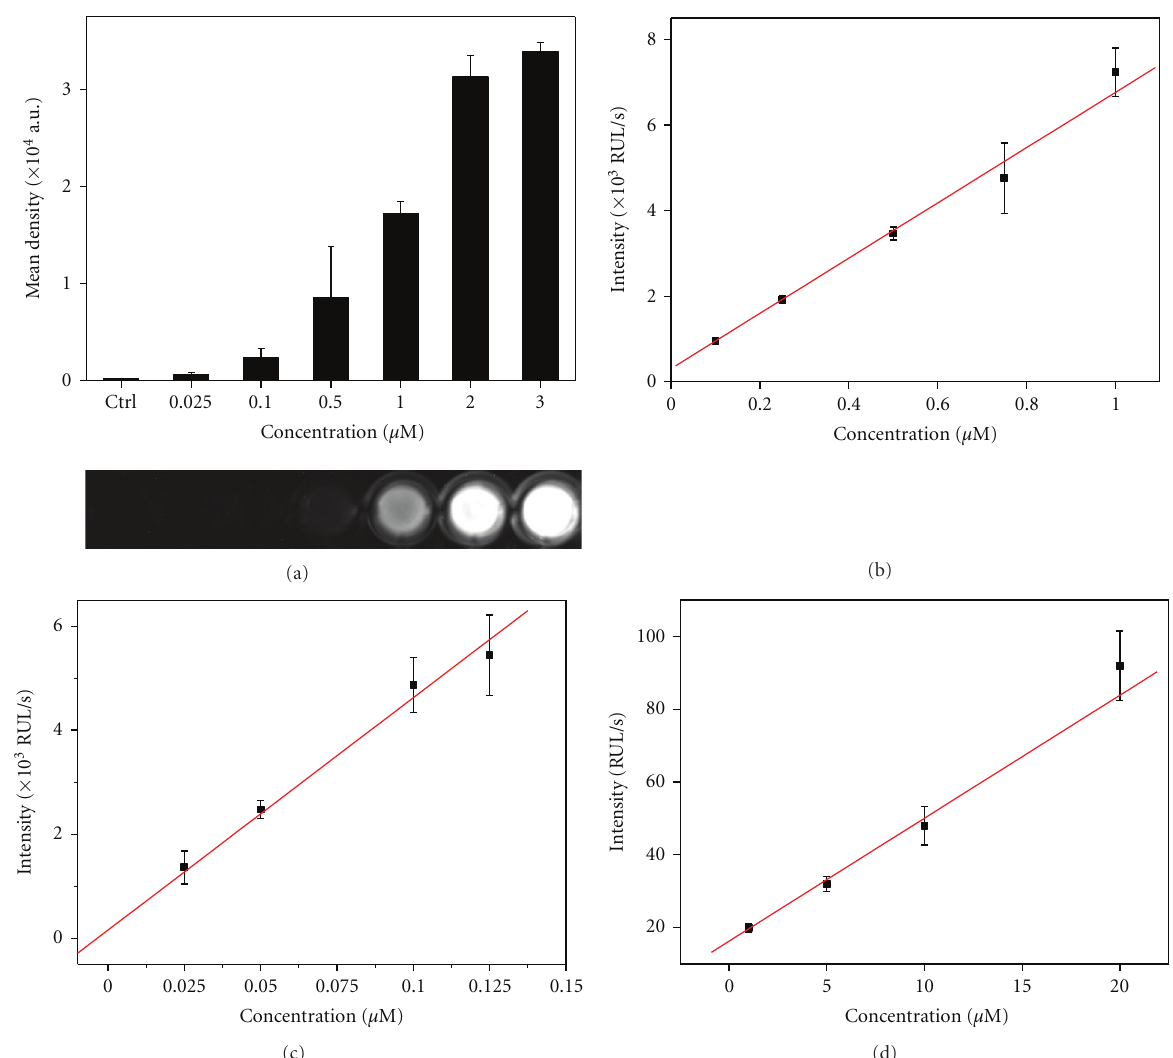
Figure 3: (a) Imaging of chemiluminescence produced by the POMs (2.5mg/mL) with H 2 O 2 at various concentrations; (b), (c), and (d) Correlation of the POMs (2.5mg/mL) to various concentrations of H 2 O 2 in PBS under di ff erent operating voltage (OV). (b) OV = − 500 eV; (c) OV = − 600eV; (d) OV = −